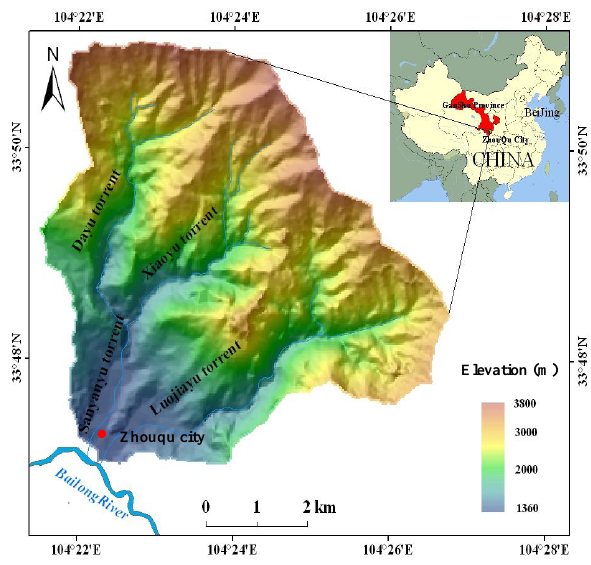
Fig. 1. The debris flow locations near Zhouqu City. 15